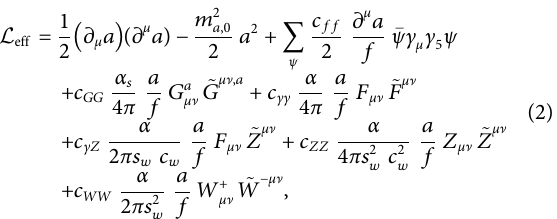
Figure 3. Due to its minimality, the model is highly testable [67, 68]. In particular, leptogenesis constrains the fl avor mixing pattern beyond the experimental fi ts shown in Figure 1, which can be tested by comparing fl avored branching ratios in displaced decays. Finally, if accessible, HNL oscillations in the detectors are sensitive to the HNL mass splitting [44], which is a crucial parameter for